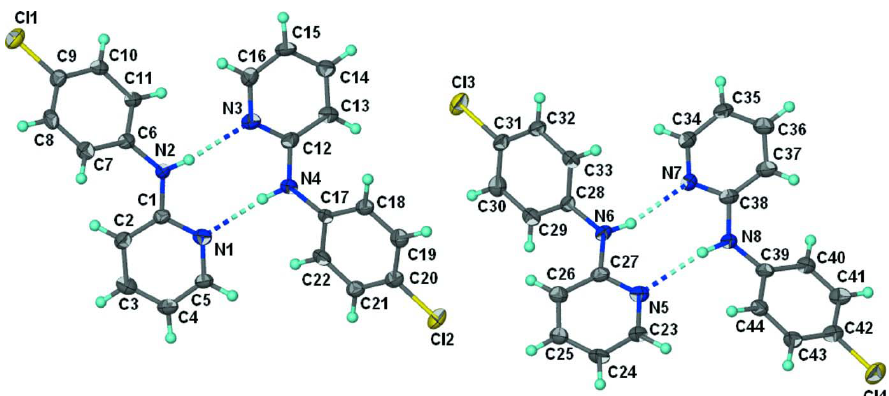
H N Cl molecules. 11 9 2